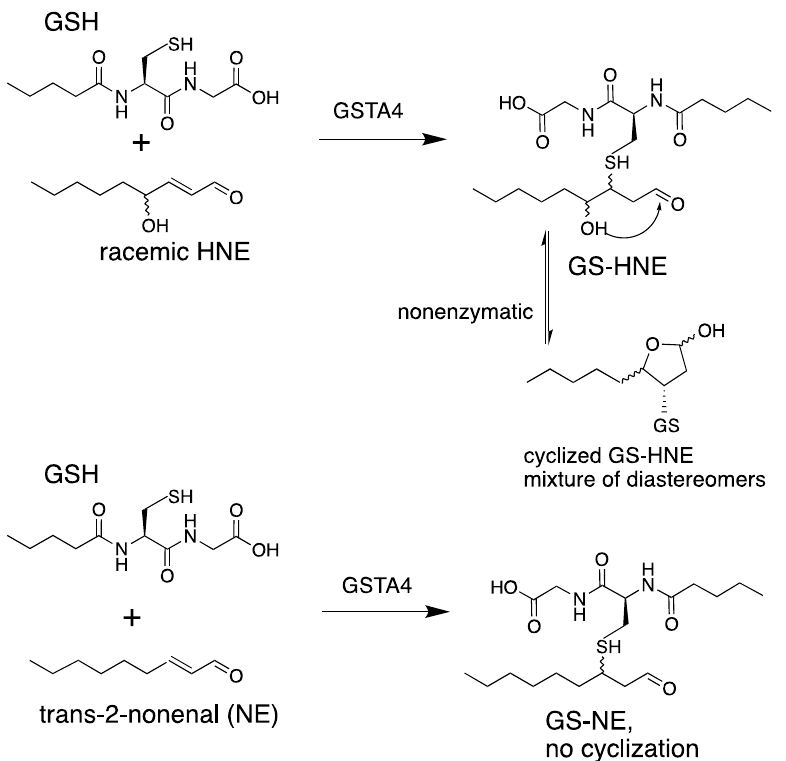
Figure 1. GSTA4-4-catalyzed reaction of lipid alkenals with GSH. The GS-HNE product ( top ) undergoes nonenzymatic cyclization to a mixture of isomers. The GS-NE product ( bottom ) does not cyclize. Curved lines indicate stereochemical heterogeneity.